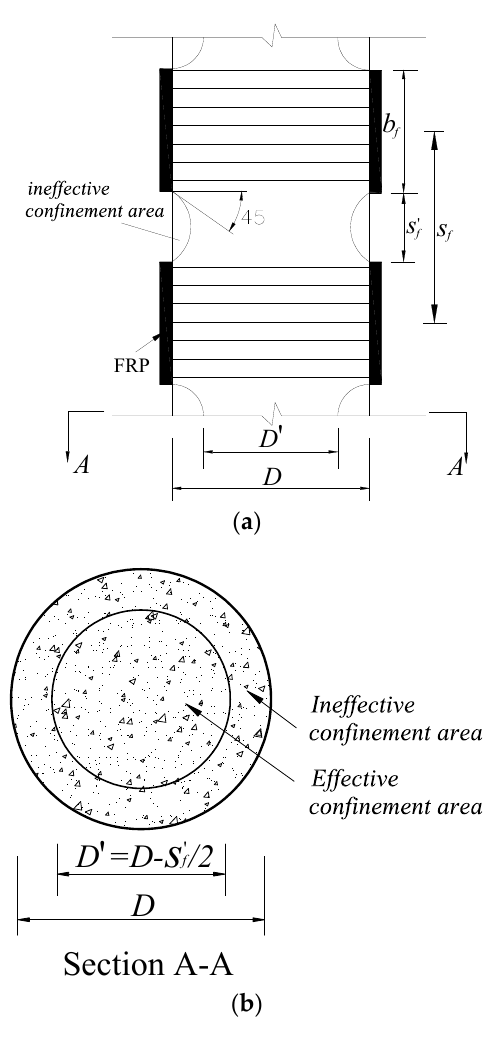
Figure 2. Effective confinement area in a circular column partially wrapped with FRP. ( a ) Arching action; ( b ) Effective confinement area at the center level of a strip.